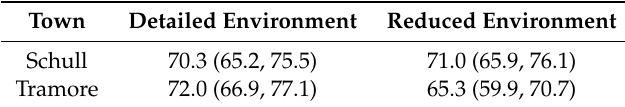
Table 1. Percent of runs leading to an outbreak for the detailed environment model and the reduced fidelity environment